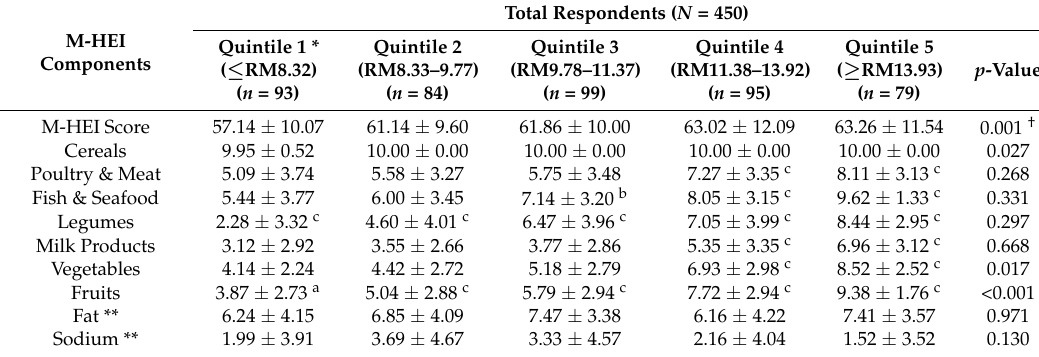
Table 3. Relationships between mean M-HEI component scores and energy-adjusted DDC quintiles.